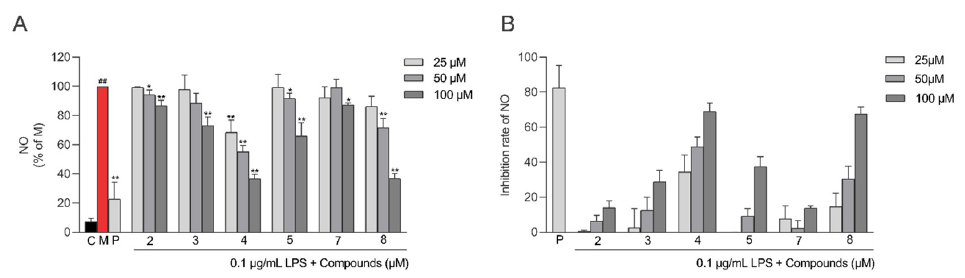
Figure 7. Inhibitory effects of compounds 2 – 5, 7 , and 8 on lipopolysaccharide (LPS)-induced NO production in RAW264.7 cells. ( A ) Relative NO content in RAW264.7 cells of each group. ( B ) The inhibition rates of LPS-induced NO production by the compounds (mean ± SD, n = 3). Statistical analysis: ## p < 0.01 vs. the control group; * p < 0.05; and ** p < 0.01 vs. the LPS-treated model group. C: control group, M: model group, and P: positive group.